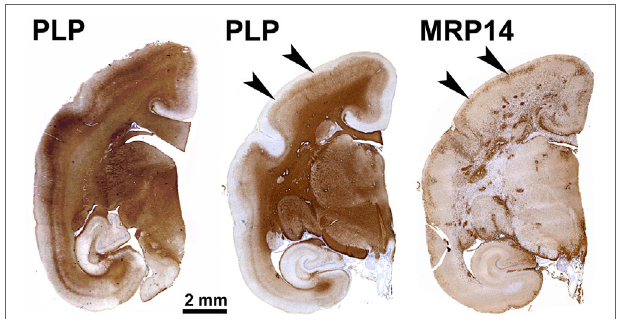
FiGURe 1 | Patterns of demyelination (PLP) and inflammation (MRP14) in a marmoset immunized with multiple sclerosis myelin/complete Freund’s adjuvant. This archetypical experimental autoimmune encephalomyelitis model is characterized by abundant MRP14 + resident (microglia) and infiltrated (macrophages) myeloid cells, which are found in multiple dense clusters in the white matter and as a band at the rim of subpial demyelinated lesions